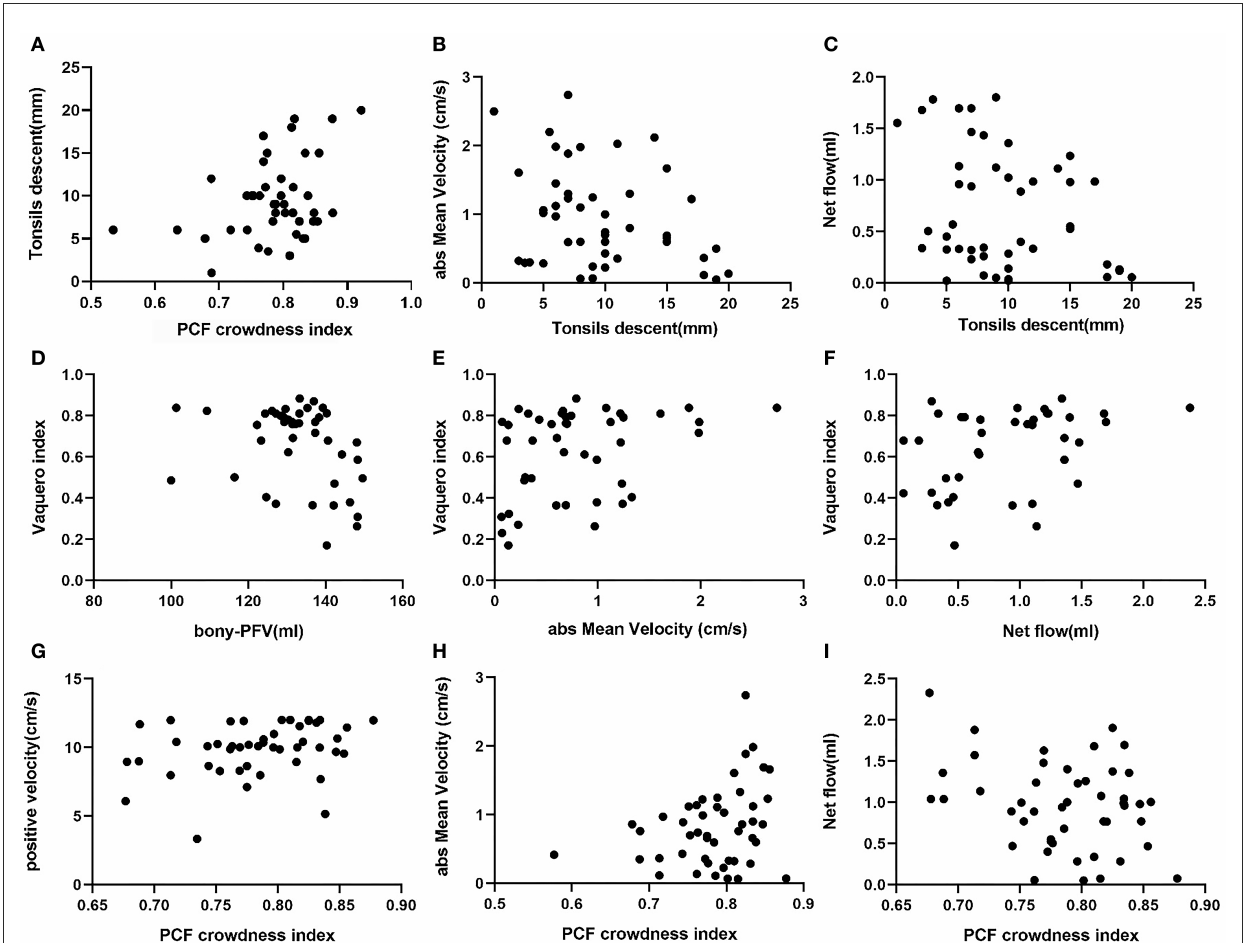
FIGURE3 Scatter plots of correlations between characteristic morphological and physiological measurements of CMI: (A) PCF CI associated with tonsillar descent, (B) tonsillar descent associated with absMV, (C) tonsillar descent associated with CSF net flow, (D) bony-PFV associated with, (E) absMV associated with VI, (F) CSF net flow associated with VI, (G) PCF CI associated with PVmax, (H) PCF CI associated with absMV, and (I) PCF CI associated with CSF net